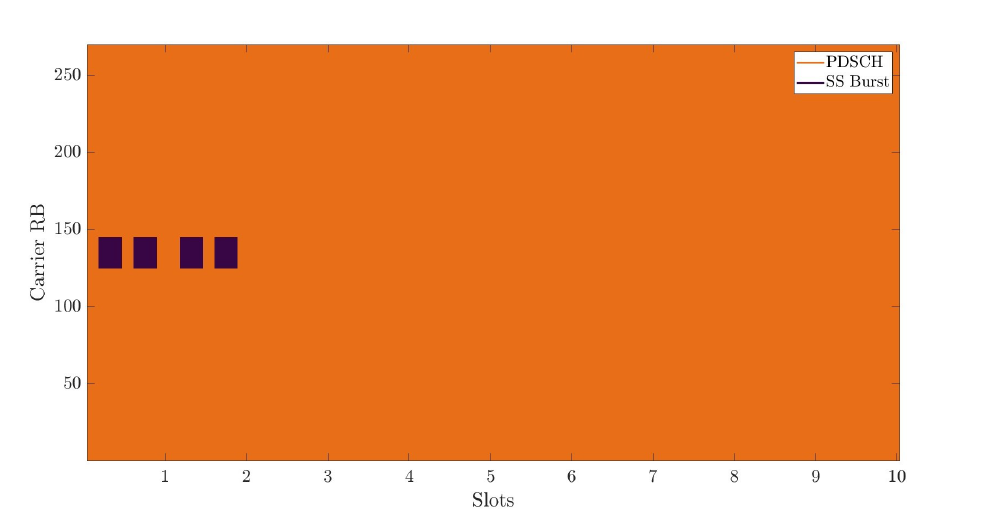
Figure 5. Resource grid fully allocated for data payload.